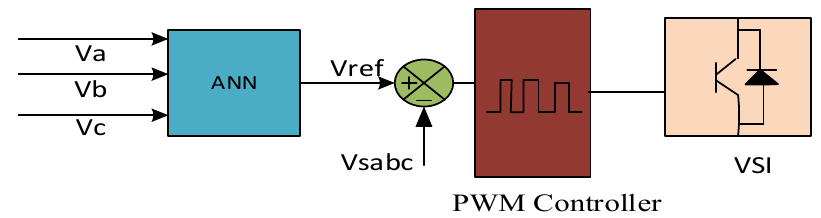
Figure 13. Block diagram of Series ANN model.